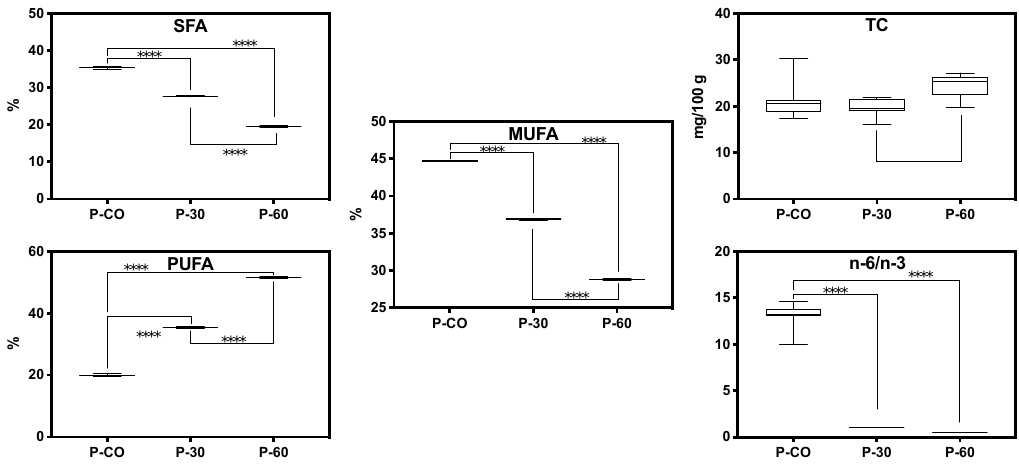
Figure 1. SFA—Saturated fatty acids; MUFA—Monounsaturated fatty acids; PUFA—Polyunsaturated Figure 1. SFA — Saturated fatty acids; MUFA — Monounsaturated fatty acids; PUFA — fatty acids; TC—Total cholesterol; n-6 / n-3—ratio of omega-6 / Polyunsaturated fatty acids; TC — Total cholesterol; n-6/n-3 — ratio of omega-6/omega-3.